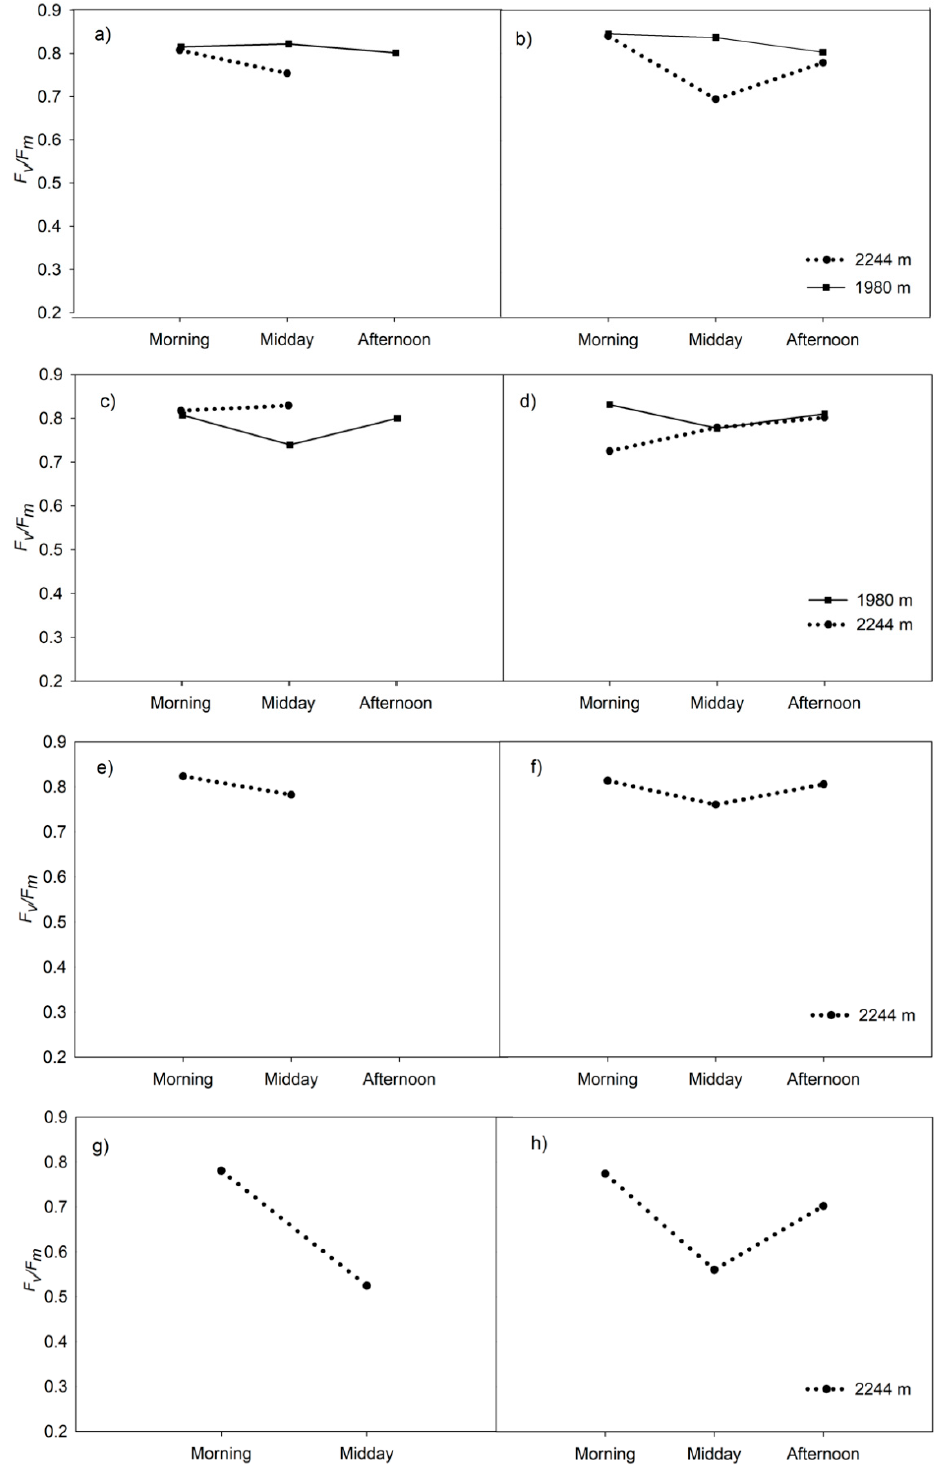
Figure 4. Changes in the photochemical efficiency of PSII, F v / F m , throughout the day in Erysimum penyalarense ( a , b ) and Senecio carpetanus ( c , d ) from contrasting elevations (1980 and 2244 m); as well as in Hieracium vahlii ( e , f ), and Jurinea humilis ( g , h ) growing at 2244 m. Measurements were taken at the time of sample collection for the VAZ analysis in the 2018 (left panel) and 2019 (right panel) growing